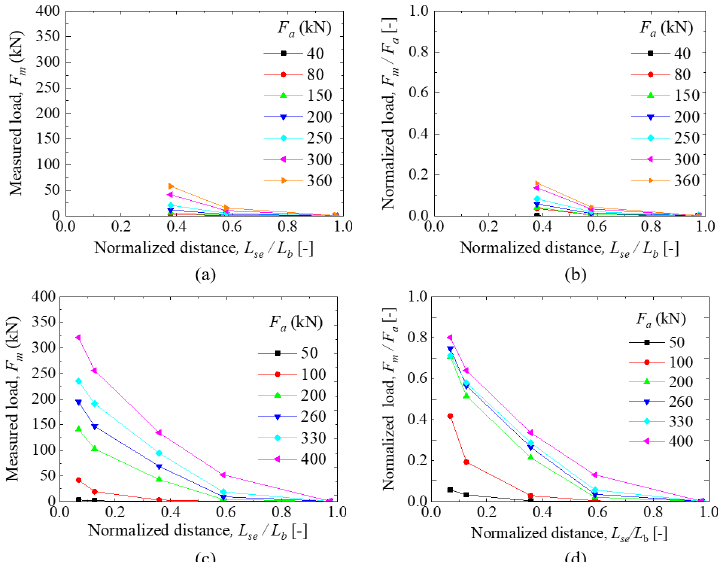
Figure 12 - Load distribution on bonded length of anchors T10 and T36: (a) Anchor T10: measured load v. normalized distance; (b) Anchor T10: normalized load v. normalized distance; (c) Anchor T36: measured load v. normalized distance; (d) Anchor T36: normalized load v. normalized